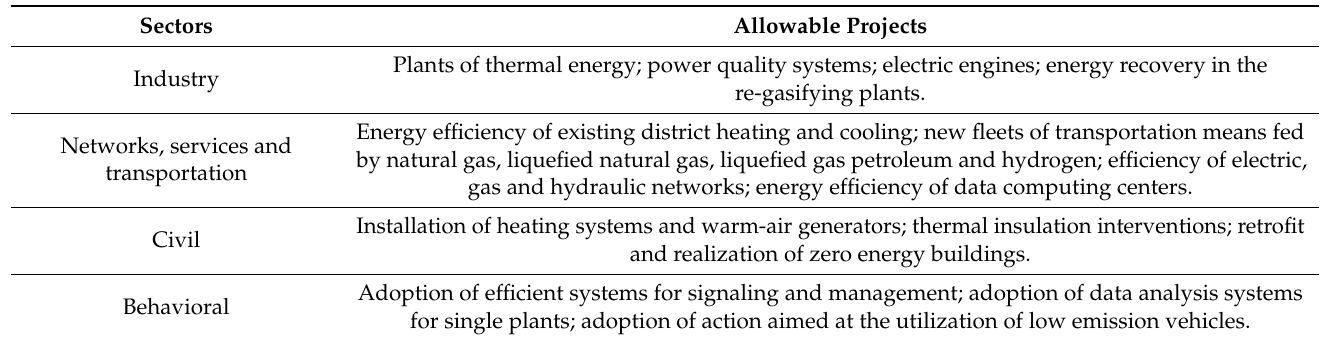
Table 6. Projects eligible for the efficiency transfer system in the public administrations. Allowable